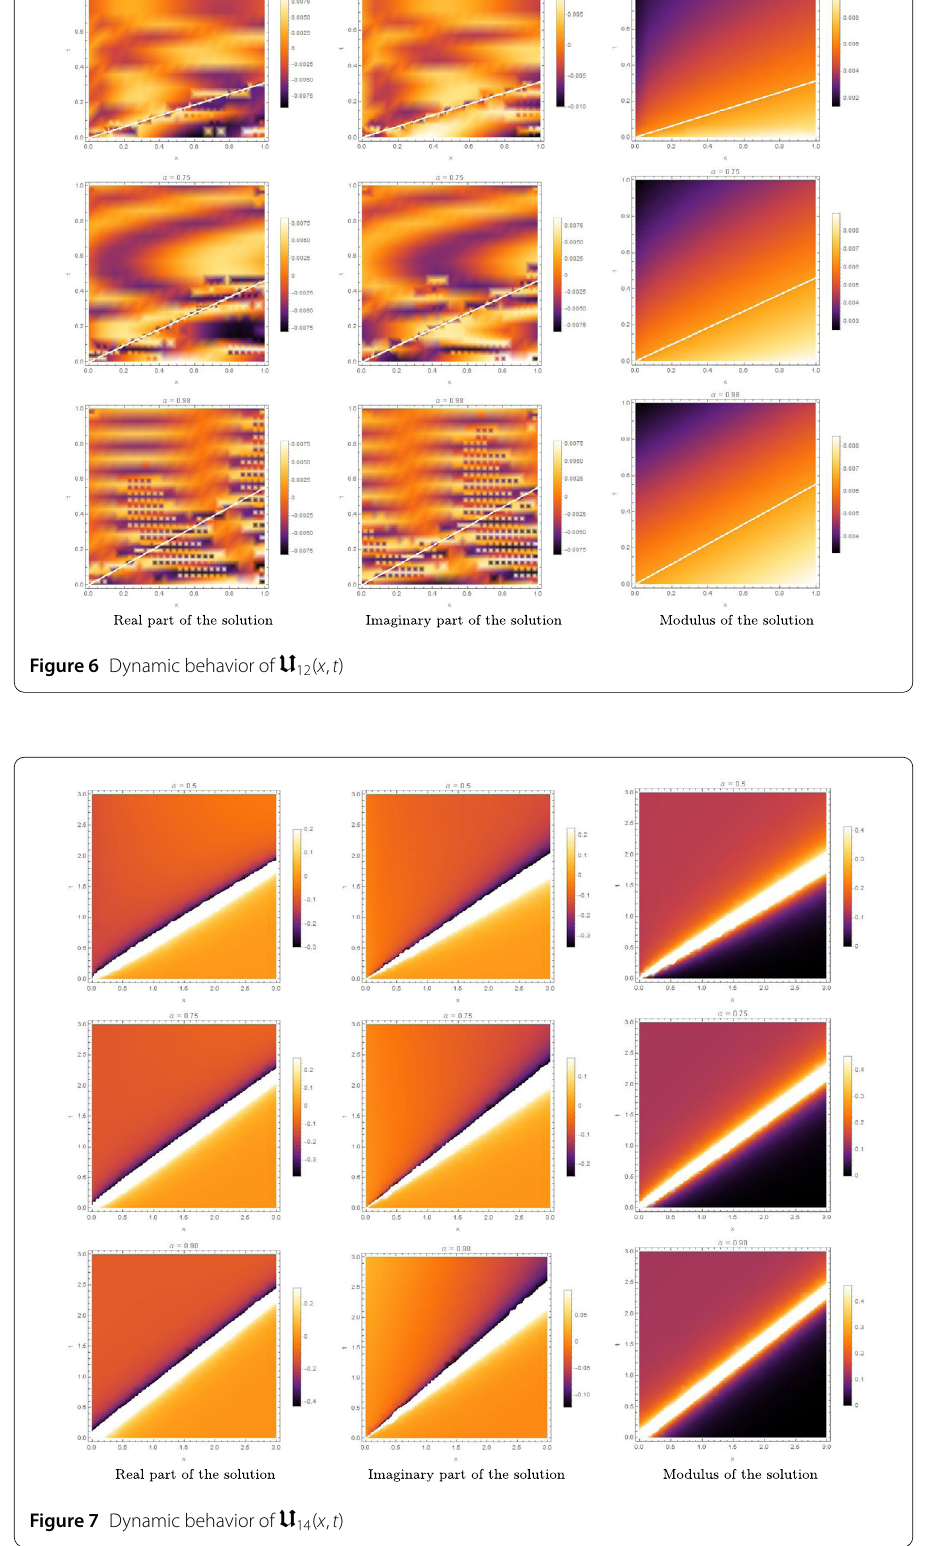
Figure 7 Dynamic behavior of U 14 ( x , t